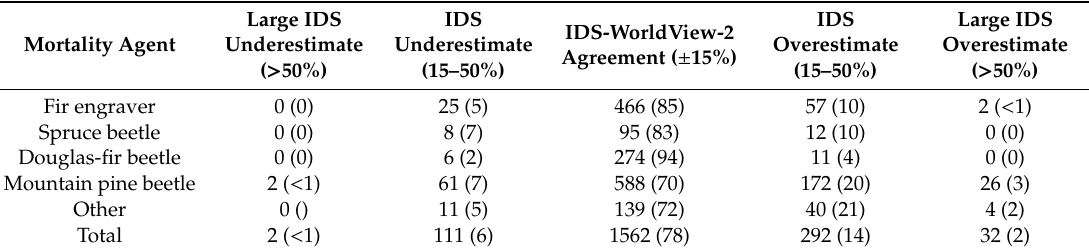
Table 8. Severity estimation accuracy of IDS polygons by mortality agent using the FHP method. Percentages are given in parentheses next to polygon counts. N = 1999 polygons total. Overall accuracy = 78.1%.